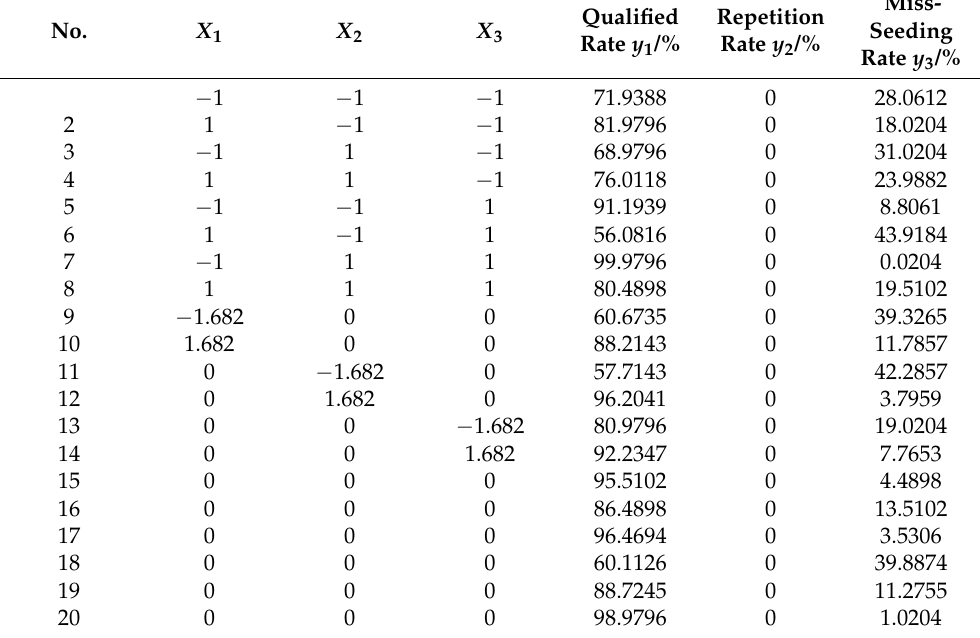
Table 2. Test results.